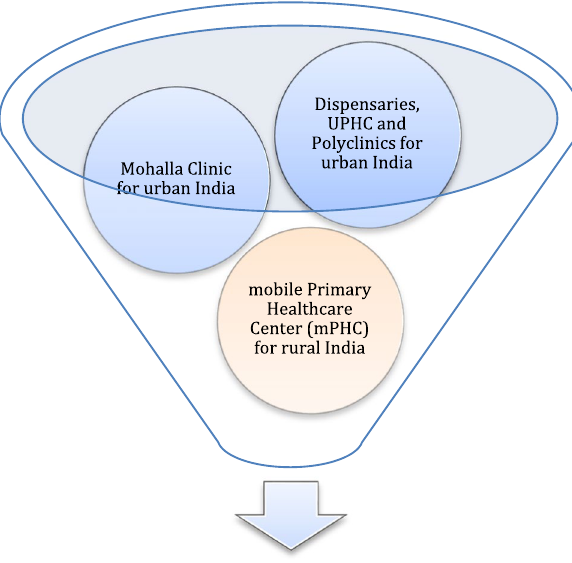
Fig. 8 A conceptual model showing the proposed mobile Primary Health Center (mPHC) as the missing component to complete the Universal Health Coverage